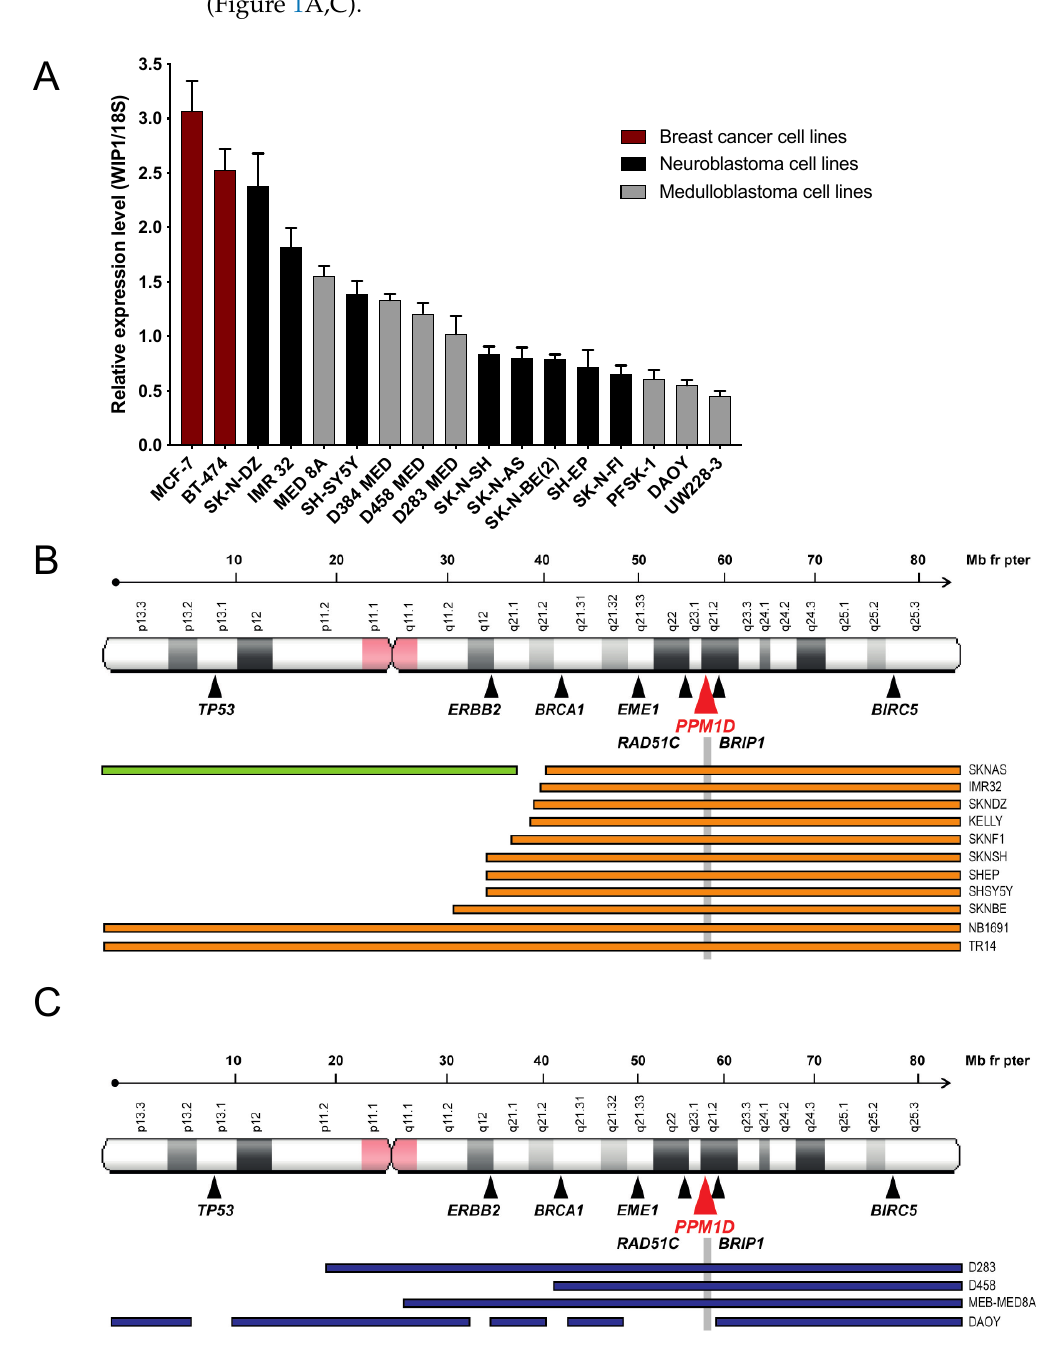
Figure 1. PPM1D expression correlates to 17q copy number gain. ( A ). PPM1D is expressed at different levels in neurob- lastoma and medulloblastoma cell lines. Relative PPM1D mRNA expression in two PPM1D -amplified breast cancer cell lines (pink bars), eight neuroblastoma (NB) cell lines (black bars), six medulloblastoma (MB) cell lines (grey bars) and the supratentorial primitive neuroectodermal tumor (sPNET) cell line PFSK-1 (grey bar), analyzed with real-time PCR. The breast cancer cell line MCF-7 is amplified for PPM1D and used as a positive control for PPM1D mRNA expression. Means with S.D. of three experiments are displayed. ( B ). Chromosome 17q ploidy in neuroblastoma cell lines. Summary of whole or segmental chromosome 17 gain reported in neuroblastoma cell lines [42,43]. ( C ). Chromosome 17q ploidy in in medulloblastoma cell lines. See Figure S1 for details.